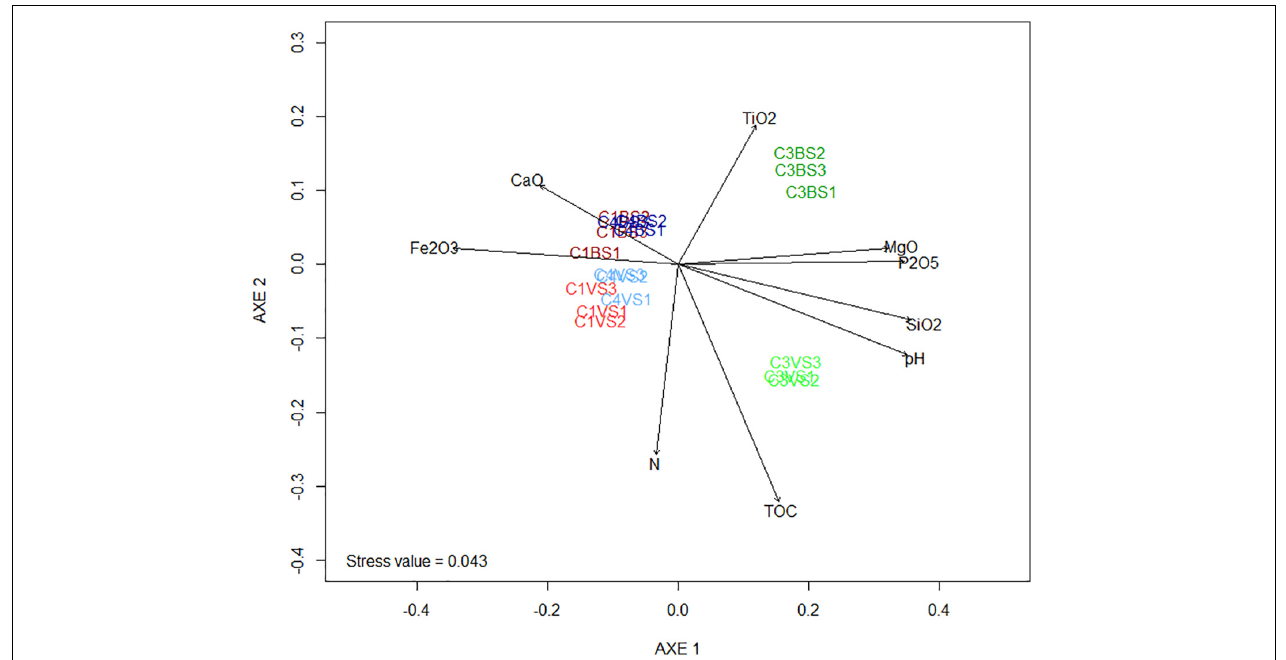
FIGURE 3 | Non-metric multidimensional scaling (NMDS) presenting the differences of the microbial communities between the different replicates of phosphate mining waste samples. The stress values were < 0.05, indicating that these data were very well represented by the two-dimensional representation. Arrows are the projections of possible explanation variables obtained by vector fitting. Only correlations with a false discovery rate (fdr) corrected p < 0.05 were indicated. The angle and length of the vector indicate the direction and strength of the variable. The r 2 correlation coefficient and the p -values are presented in Supplementary Table 3 .